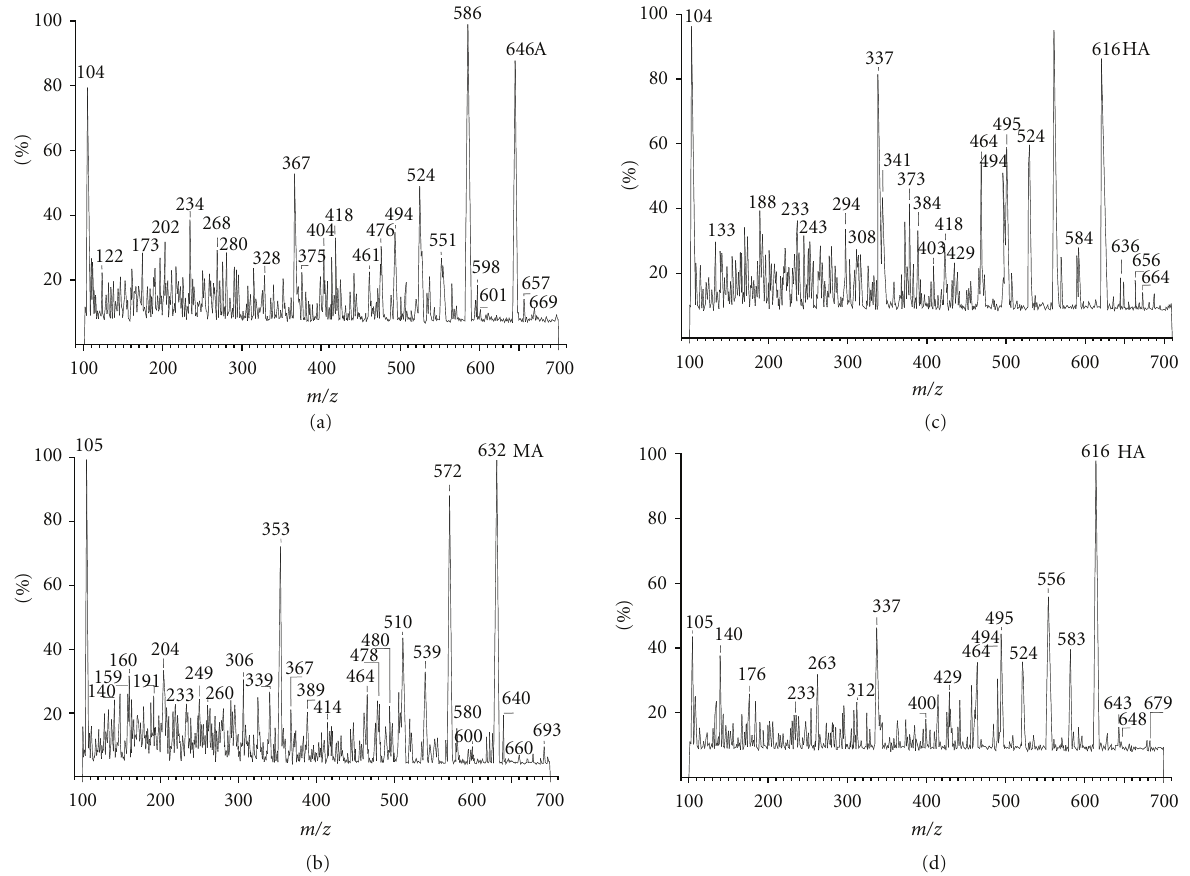
Figure 5: ESI/MS/MS spectra of A standard (a), HA standard (c), MA standard (b), and HA in decocted Chuanwu (d).